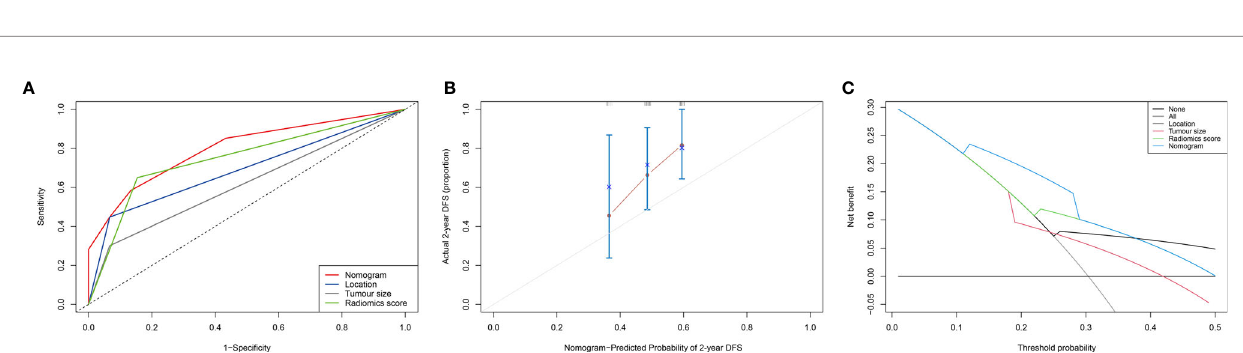
FIGURE 4 | Evaluation of the radiomics score-based nomogram. (A) The receiver operating characteristic (ROC) curve; (B) Calibration curve for the radiomics nomogram in the cohort. The x-axis shows the predicted probability of a DFS event. The y-axis shows the actual DFS outcome; (C) Decision curve analysis (DCA) of the radiomics nomogram. The threshold probability was calculated for a 2-year DFS event. For reference, the four strategies “ nomogram ” , “ radiomics score ” , “ location ” and “ tumour size ” are displayed. The radiomics score-based nomogram model showed larger net bene fi t values than the other models (0.12-0.38).